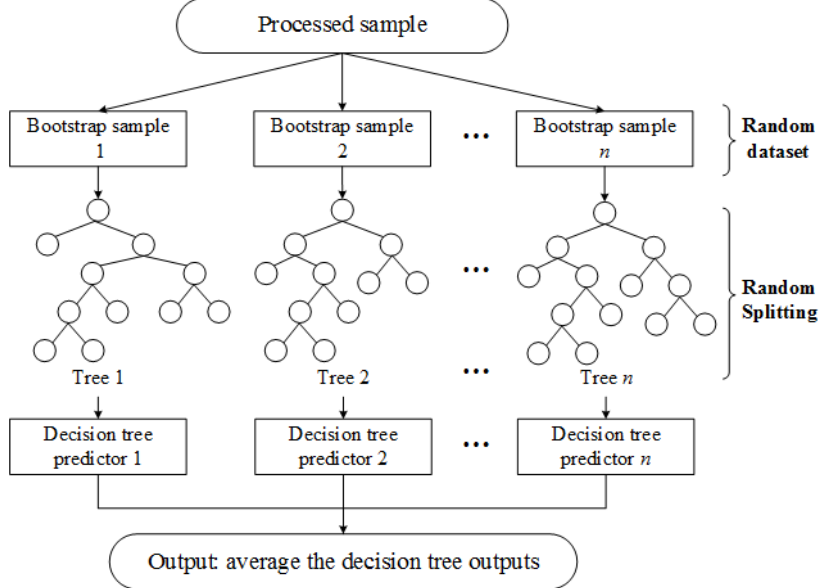
Figure A1. The schematic diagram of random forest